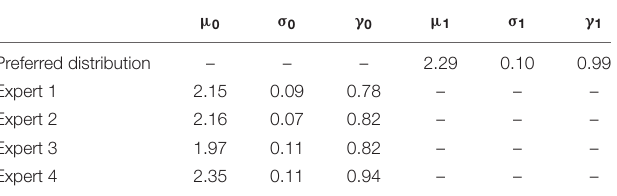
π ( θ ) and π ( θ | y ) can be found in Table 3 . We can see, d